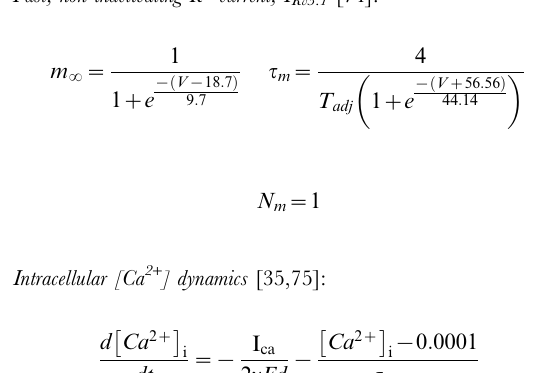
t decay Dendritic channel distribution. All dendritic channels except for I h , Ca LVA and Ca HVA were uniformly distributed. I